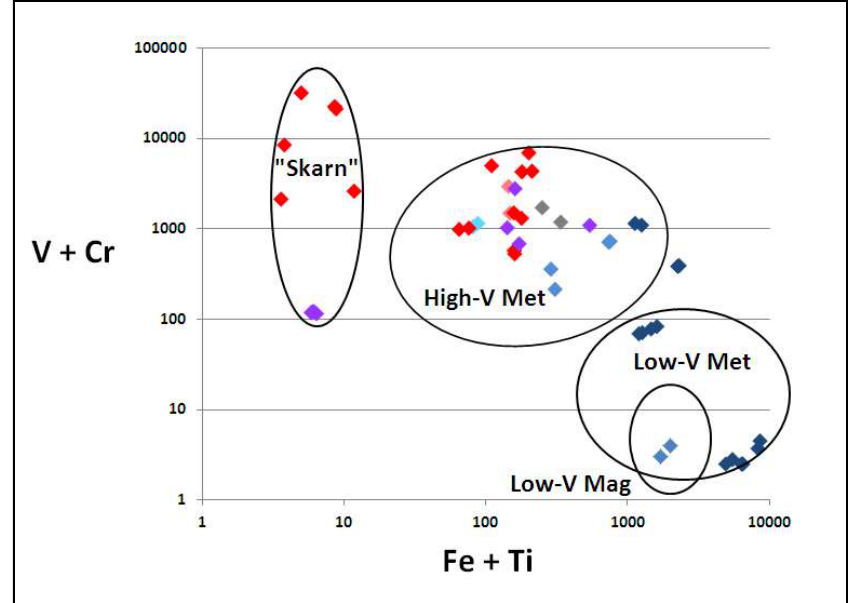
Figure 21. V + Cr vs. Fe + Ti diagram showing Mogok gem corundum, as color coded plots, as in Figure 19, within outlined fields for Mogok data from [11,13]. Note the extreme V + Cr enrichment and extreme low Fe + Ti for the suggested Mogok “Skarn field”. Such low Fe + Ti is not shared by the other Myanmar or East Australian ruby data in this paper or in the cited literature.